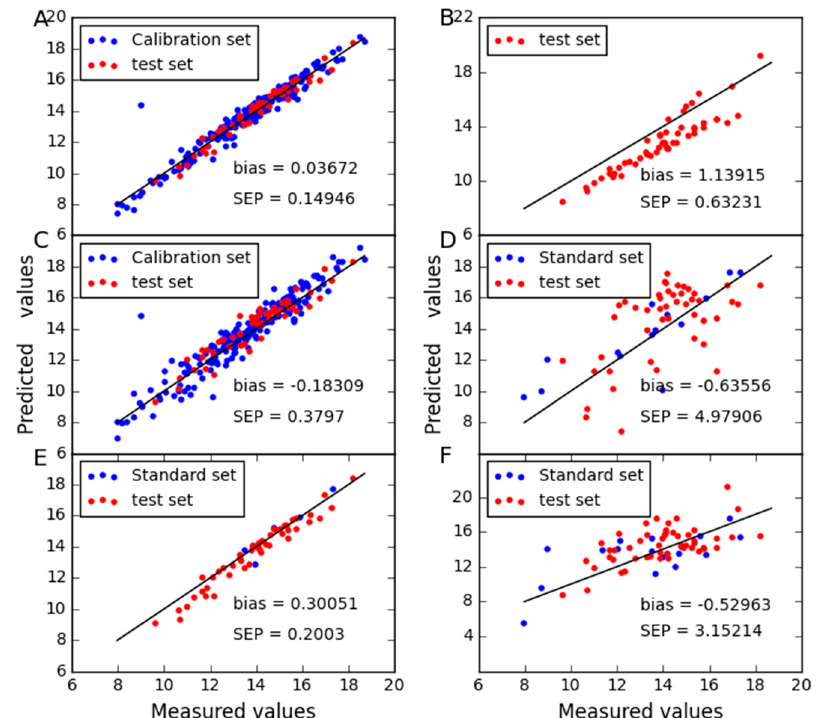
Figure 10. Protein content predicted between instruments B3 and B2 for wheat dataset as determined by ( A ) CTAI, ( B ) MSC, ( C ) TCR, ( D ) CCA, ( E ) SBC and ( F ) PDS. The blue and red dots represent the results for each sample in the train set and test set, respectively.